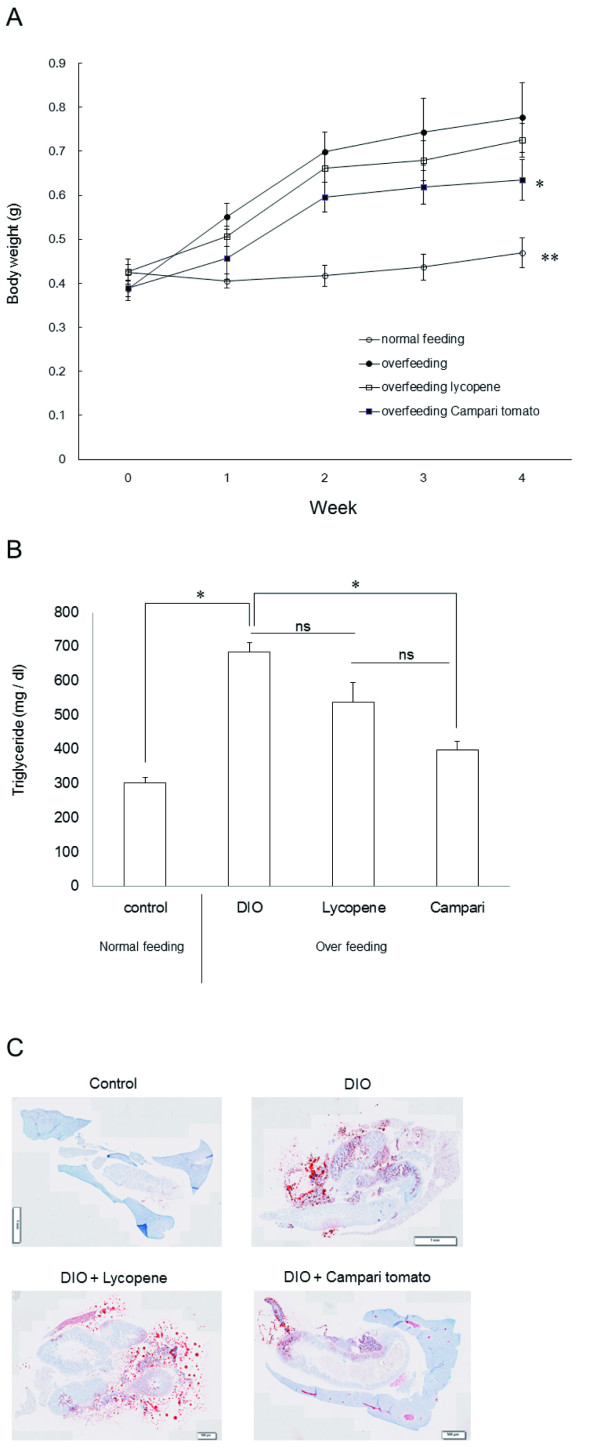
Lycopene effects on body weight, plasma TG, and hepatic steatosis in DIO-zebrafish. (A) Average body weight in each group during 4-week feeding experiments. Values are mean ± SD. Each group contained 20 samples. *P < 0.05; **P < 0.01 vs. vehicle with overfeeding, black circles. (B) Change of plasma TG levels in each group. *P < 0.05 vs. vehicle with overfeeding. (C) Oil red O staining of liver sections.